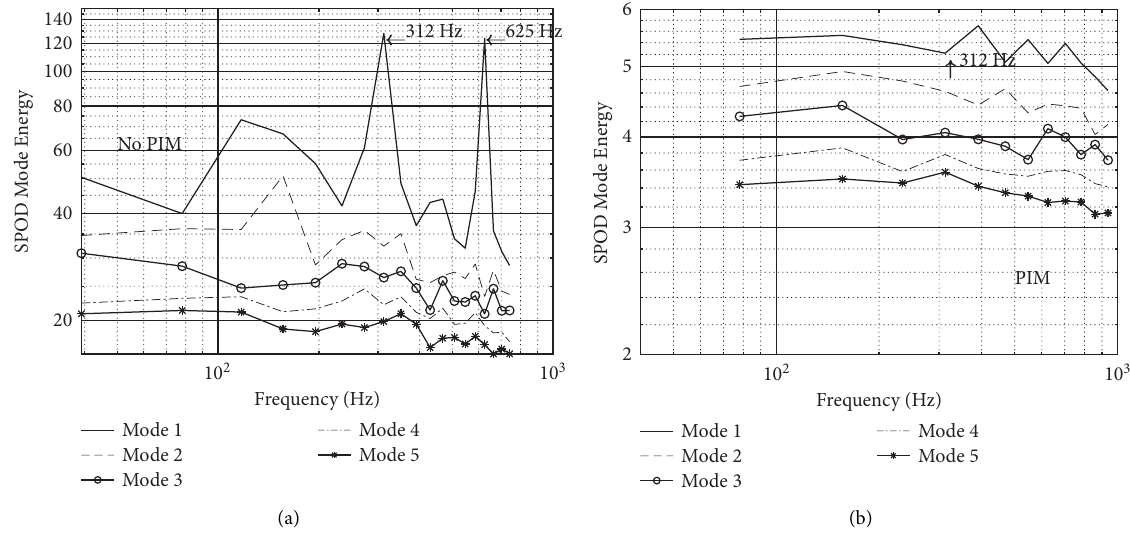
Figure 13: SPOD distribution of U ′ V ′ for the first 5 modes as a function of frequency. The no PIM (a) and the PIM (b) results are shown. Magnitude of Y -axis is different for two figures.